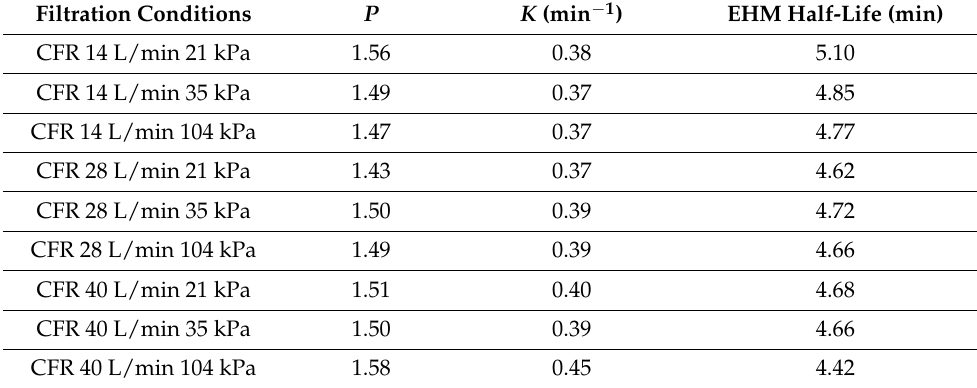
Table 8. EHM parameters for the regressions obtained in Example 3.